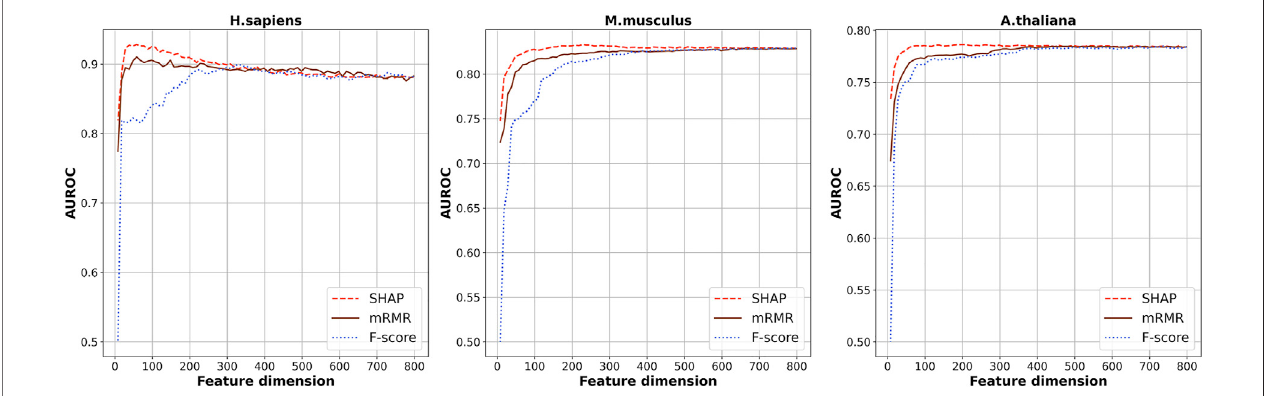
FIGURE 2 | The cross-validation AUROC values of models based on the top n features selected by SHAP, mRMR, and